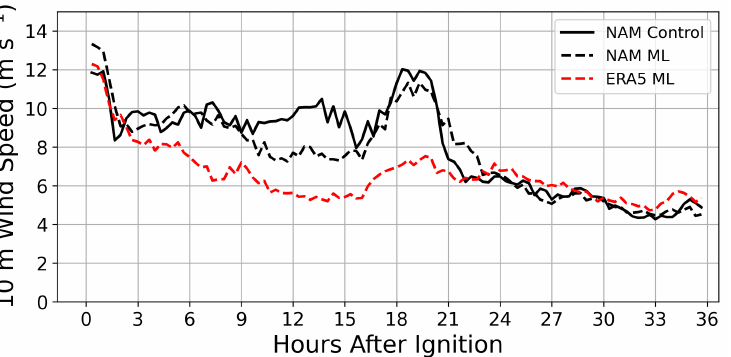
Figure 7. Time series of fire-front-averaged 10 m wind speed at model grid cells with active burning. We average across all horizontal grid cells where the fire rate of spread is >0.05 m s − 1 . Results from three select simulations are shown according to the